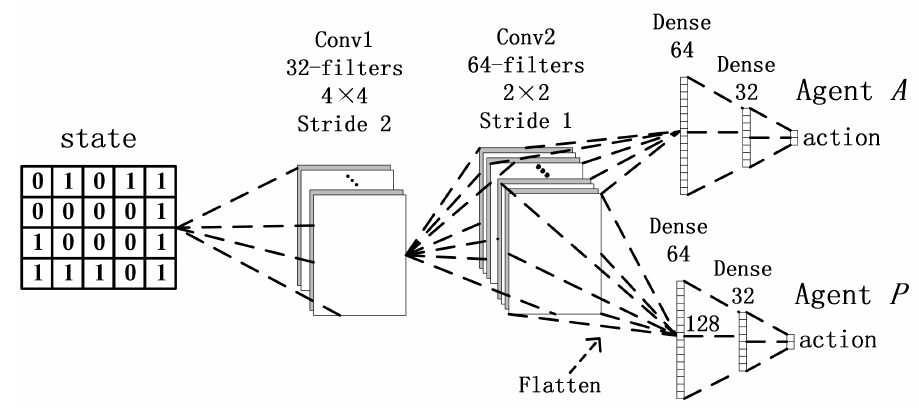
Figure 6. The network structure of the dual-agent